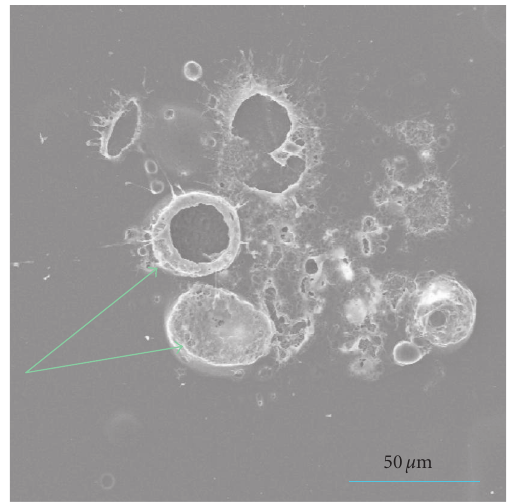
Figure 8: SEM image of collagen/PVP film surface after laser irra- diation ( F = 0 . 4J/cm 2 , 2 pulses, scale bar is 50 μ m). Green arrows show spots after bubbles formation and their subsequent collapse.